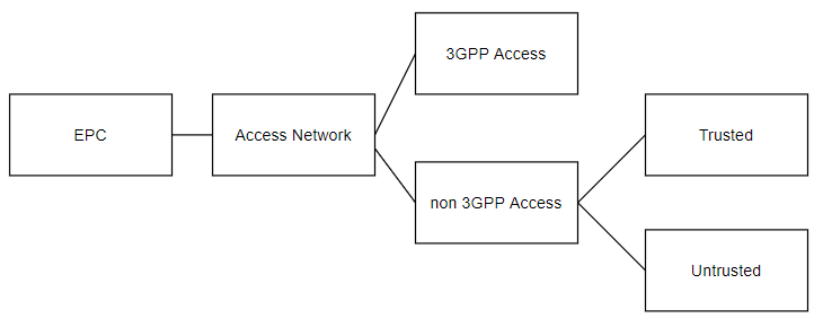
Figure 2. The architecture of LTE networks with locations in which a decision to split to 3GPP and non-3GPP access can be made to/from the user terminal (UE).